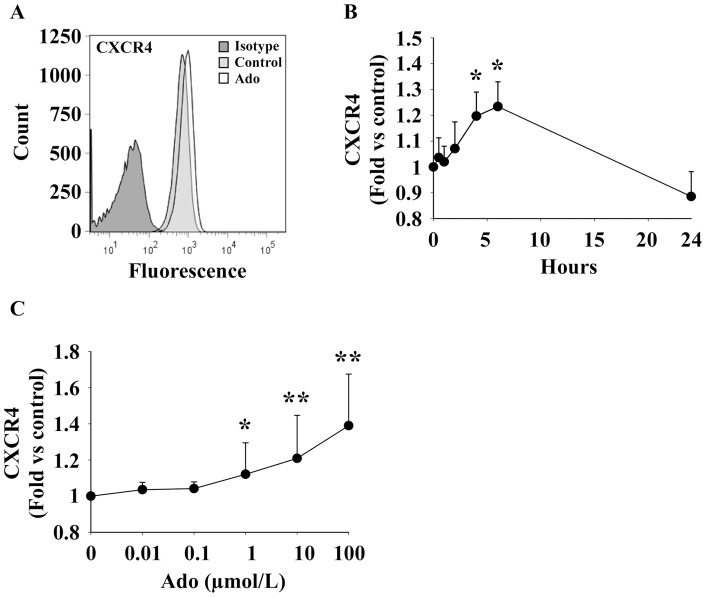
Adenosine enhances cell surface expression of CXCR4.EPC were treated with Ado and CXCR4 expression was assessed by flow cytometry. A. Representative histogram of EPC treated by 10 µmol/L Ado for 6 hours. Dark grey: isotype control. Light grey: CXCR4 staining of control cells. White: CXCR4 staining of Ado-treated cells. B. Kinetic of CXCR4 expression on EPC treated by 10 µmol/L Ado. * P<0.001 vs control (n = 10). C. Dose-dependent effect of Ado on CXCR4 expression on EPC harvested 6 hours after treatment. * P<0.05 vs control. ** P<0.01 vs control (n = 3).